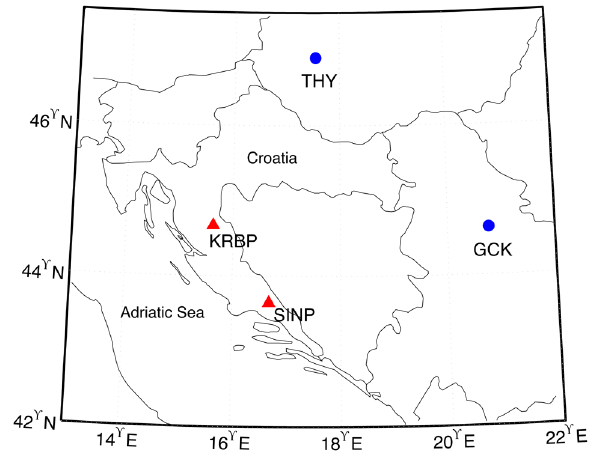
Figure 1. The positions of two Croatian repeat stations KRBP and SINP, together with two reference observatories (GCK and THY). In detail, latitude, longitude and elevation of KRBP are 44.7° N, 15.6° E, 648 m, for SINP geographical coordinates are 43.6° N, 16.7° E, 296